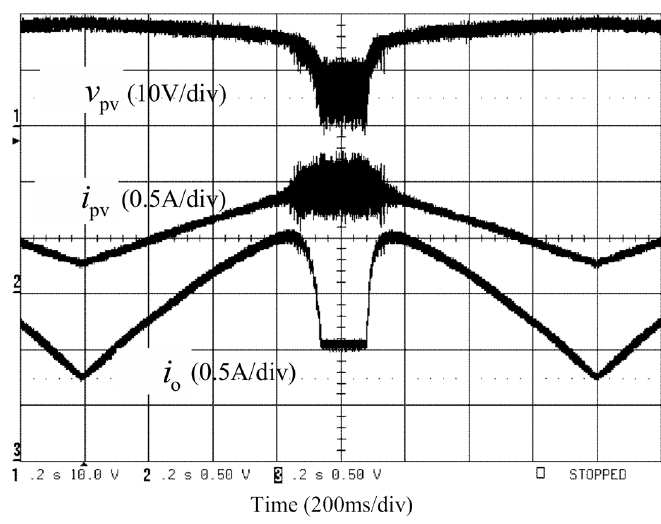
Figure 19. Behavior of PV-generator voltage ( v pv ) and current ( i pv ) as well as input-current-controlled interfacing-converter output current ( i o ), when the operating point of Raloss SR30-36 PV panel is swept from 18 V to 5 V and back.